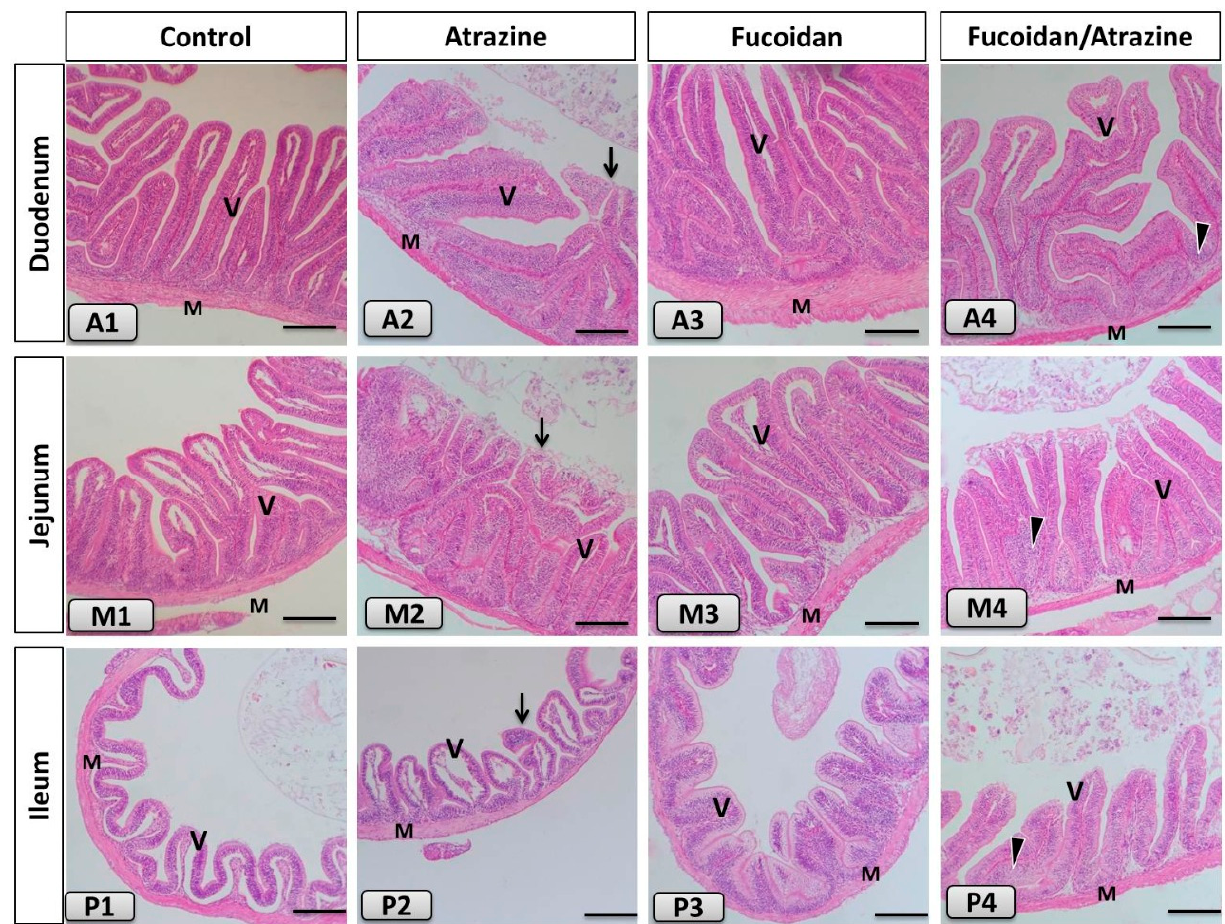
Figure 1. Histomicrograph of the Nile tilapia intestine of including duodenum (upper panel; A1 – A4 ), jejunum (middle panel; M1 – M4 ) and ileum (lower panel; P1 – P4 ) in the control group as well as other treated (Atrazine, Fucoidan, and Fucoidan/Atrazine) groups. The histological organization in the control group as well as the Fucoidan-treated groups showed normal, intact intestinal villi (V), lamina propria sub mucosa, tunica muscularis (M) and tunica serosa with enriched growth of the intestinal villi in the Fucoidan-treated group. The intestine of atrazine-treated fish revealed destruction and inflammatory cell infiltration in the intestinal mucosa with desquamation of the lining epithelium (black arrow). The Fucoidan/Atrazine-subjected group presented apparent improvement of the intestinal villi in addition to immune cell infiltration near the base of the intestinal villi (arrowhead). Stain H&E. Bar: 100 μ m.